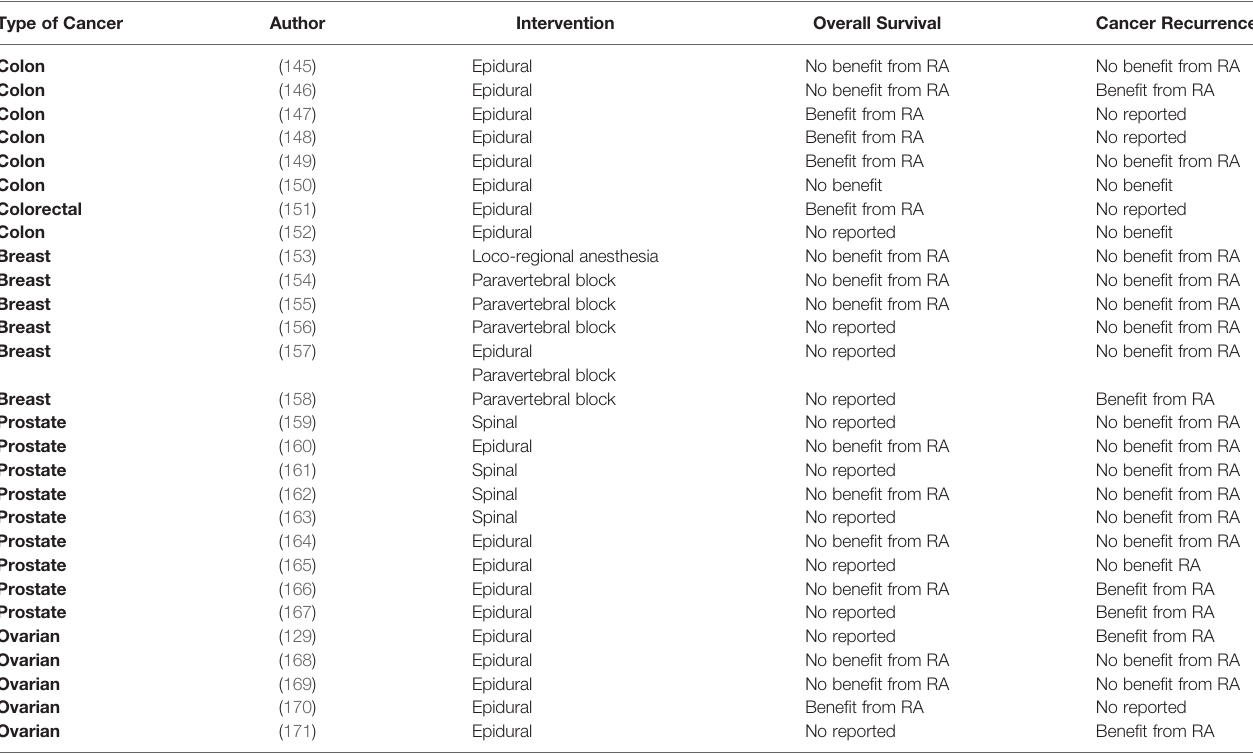
TABLE 3 | Retrospective trials assessing the effect of regional anesthesia on long-term cancer outcomes.